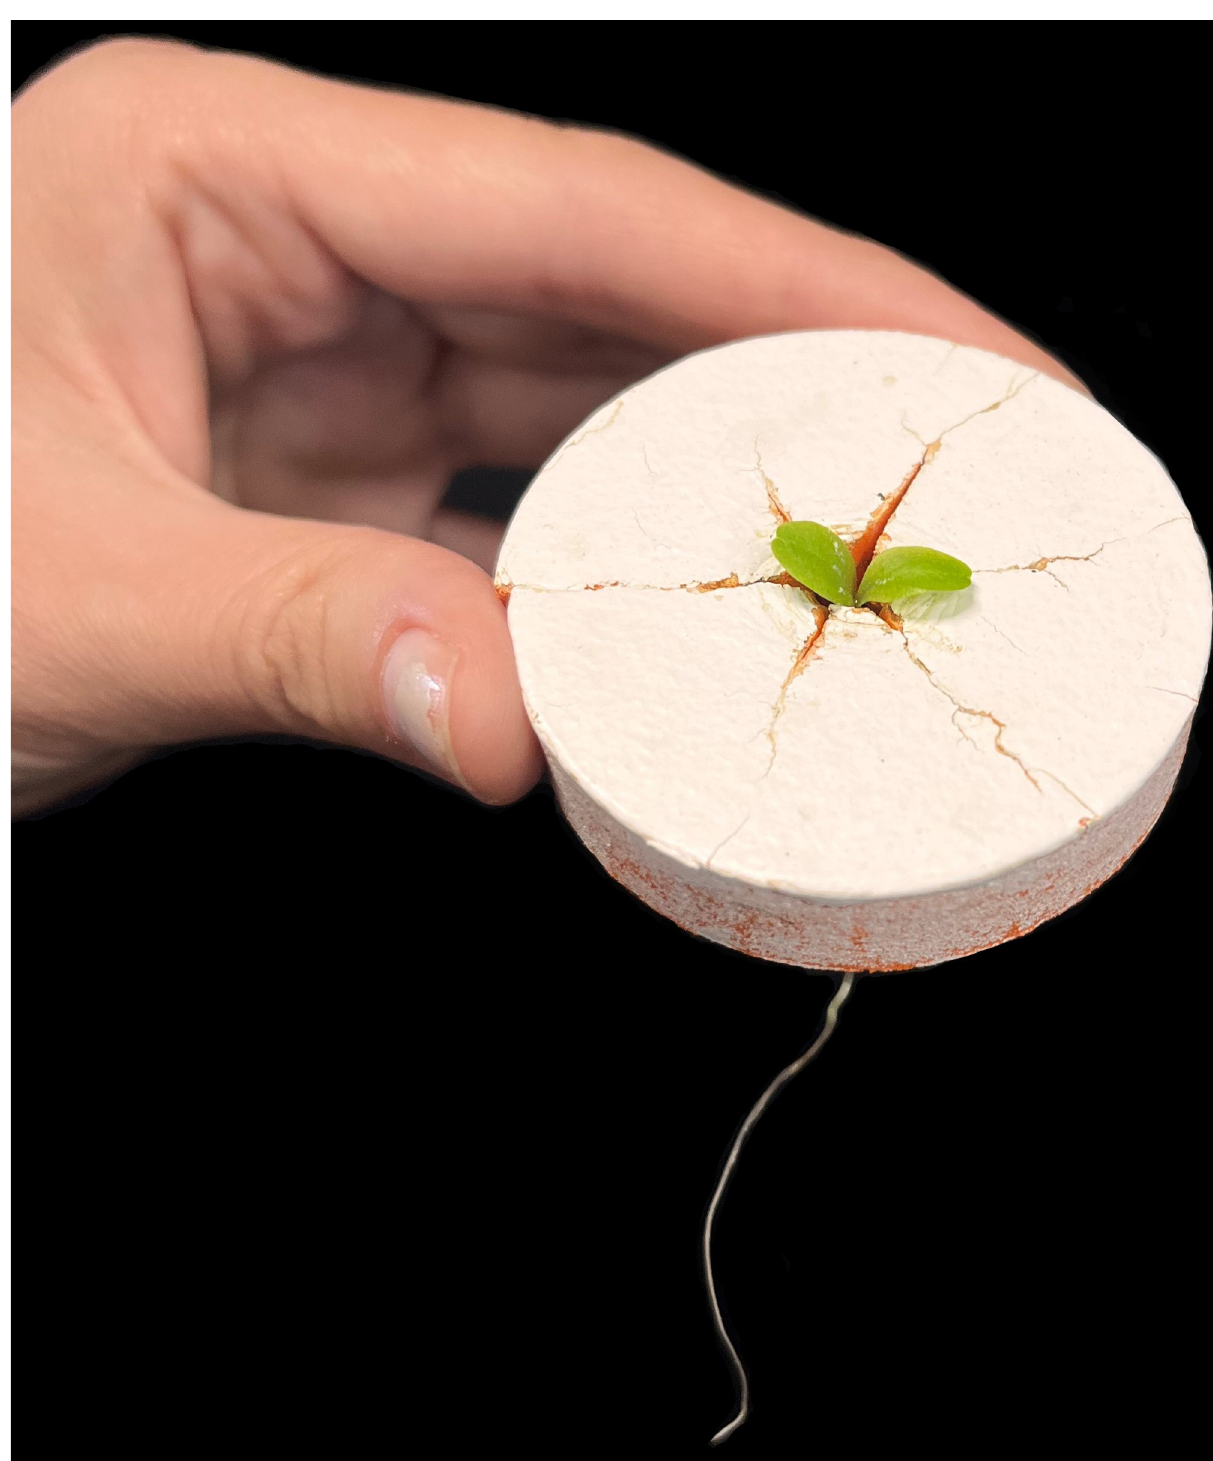
Fig 8. Neoprene cloning collar with lettuce seedling. The top of the collar has been painted white to reduce light penetration into the nutrient solution, reduce temperature, and to reflect light back to leaves for maximum growth. A radial slit in the neoprene collar runs between the thumb and the plant.